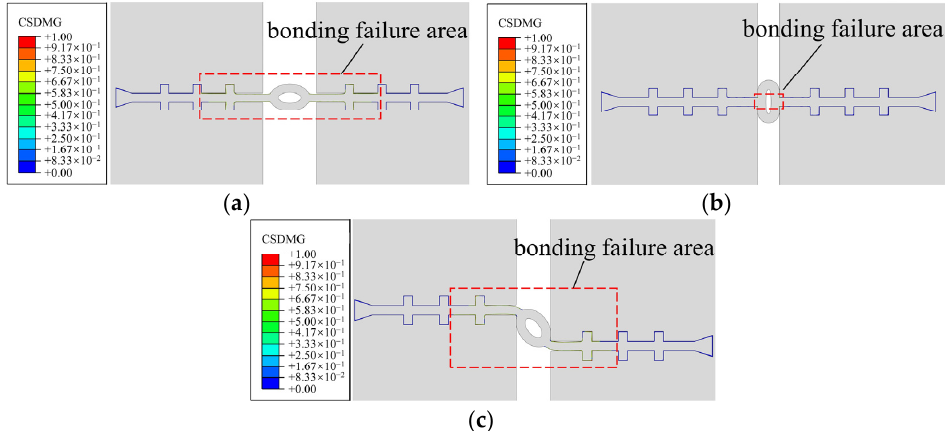
Figure 12. Damage cloud diagram of bonding stiffness in working condition 1. ( a ) 1 − 1 bonding stiffness damage. ( b ) 1 − 2 bonding stiffness damage. ( c ) 1 − 3 bonding stiffness damage.